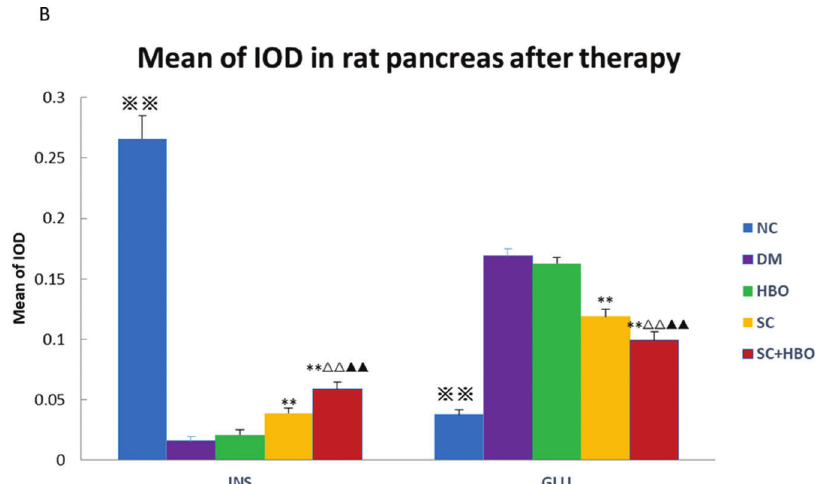
Figure 4 - Immunofluorescence analysis after 6 weeks of therapy. A. Insulin/glucagon immunofluorescence staining for pancreatic islets: In the DM group, the distribution of glucagon-positive cells (green) in the islets was disorganized, and most cells were distributed in the center and around the islets; glucagon-positive cells increased and insulin-positive cells (4) decreased as compared with those in NC group. In SC + HBO and SC groups, glucagon-positive cells in the islet center decreased and insulin-positive cells increased as compared with DM group. Scale bar: 50 m m, 200 (cid:1) . B. MOD of insulin or glucagon immunohistochemistry in pancreatic islets: The MOD values of insulin for SC + HBO and SC groups were higher than those for DM group. The MOD value of SC + HBO group was higher than the values for SC and HBO groups; the MOD values of glucagon for SC + HBO and SC groups were lower than the value for DM group, while the MOD value of SC + HBO group was lower than the values reported for SC and HBO groups. ** p o 0.01 vs DM group; mm p o 0.01 vs SC group; WW p o 0.01 vs HBO group. :: p o 0.01 vs each of the other four groups.